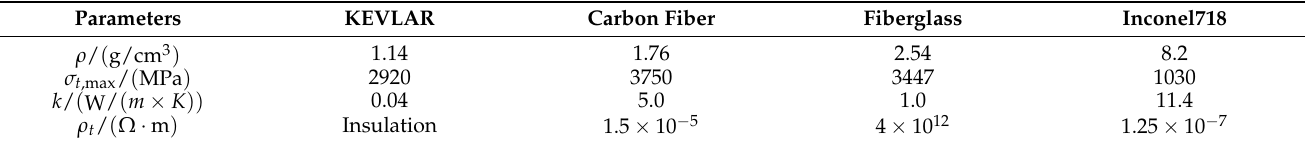
Table 2. Mechanical properties of several rotor bandage